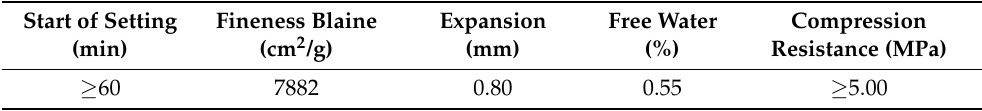
Table 1. Technical characteristics of NHL 5 hydraulic lime [44].